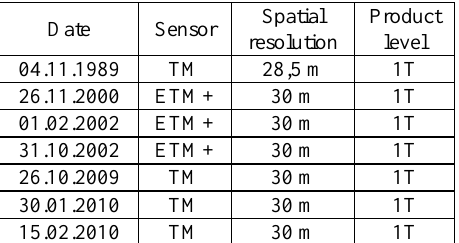
Table 2. Characteristics of satellite data